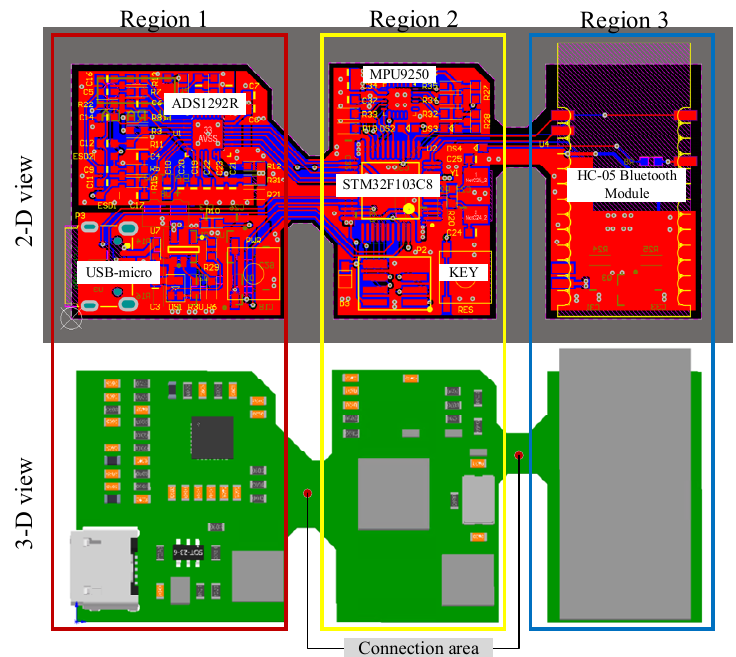
Figure 6. Circuit design drawing with dividing different areas.